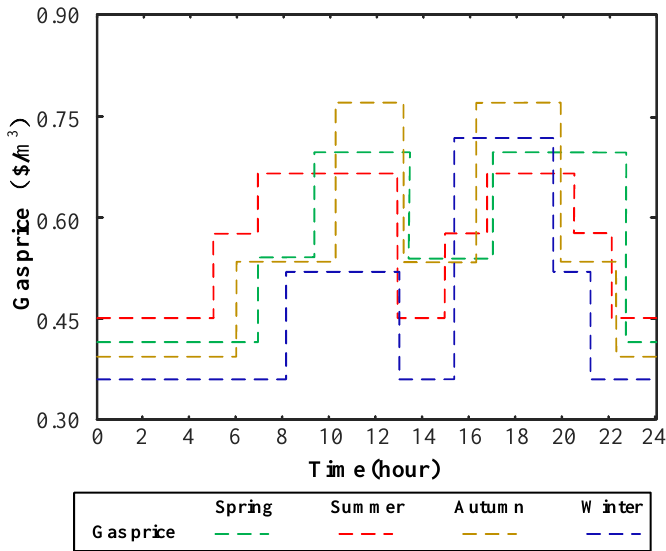
Figure 5. Seasonal time-of-use natural gas purchasing costs.